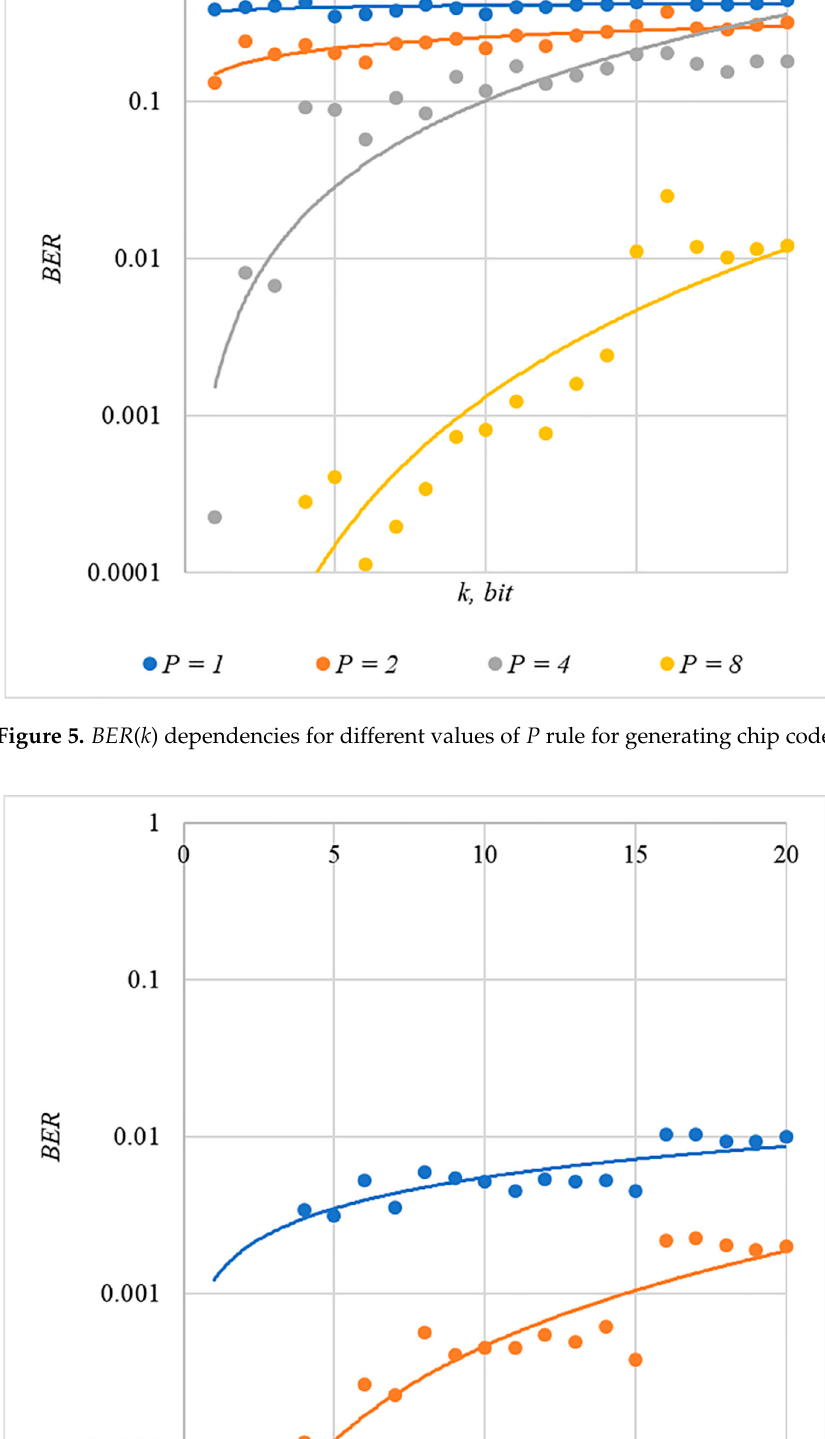
P rule for generating chip codes № 3.